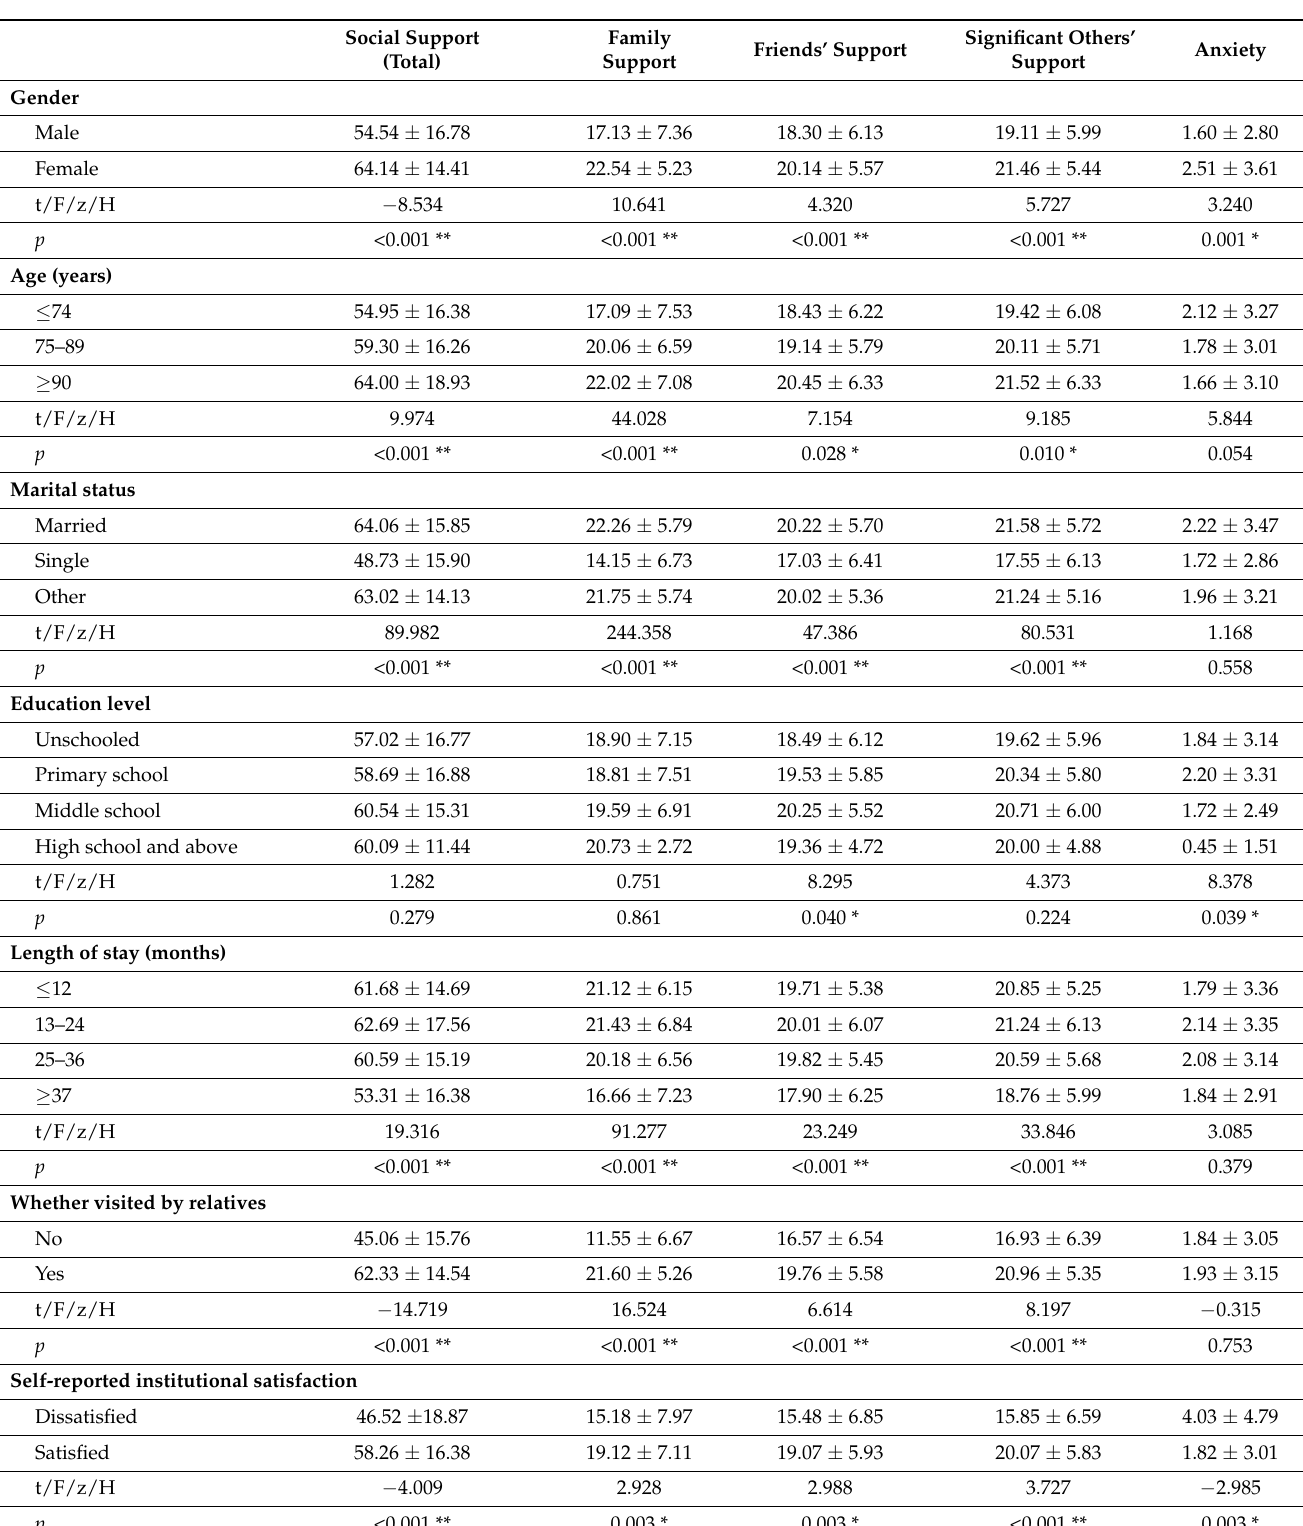
Table 2. Associations between social support and anxiety and sociodemographic variables among participants. (M ±